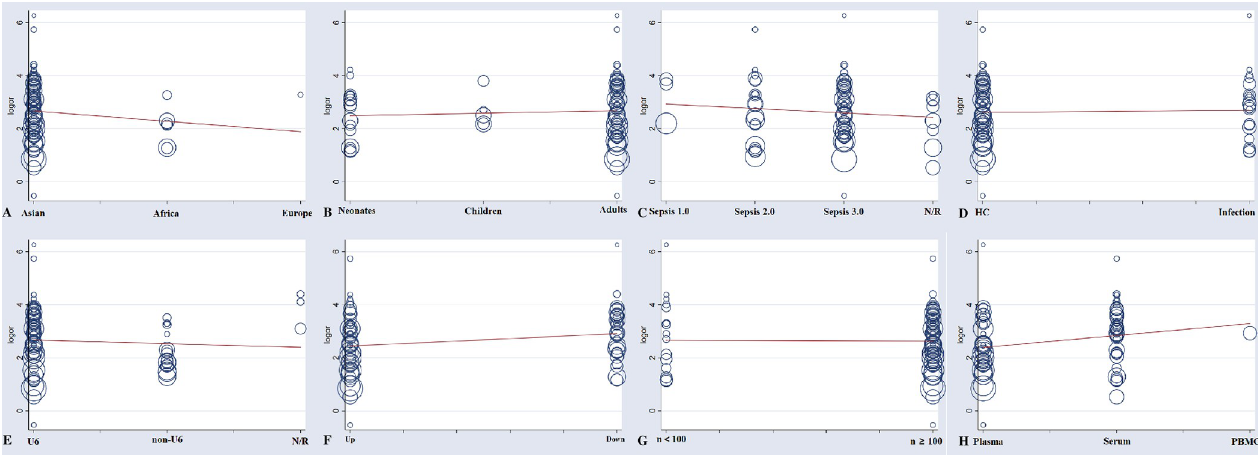
Fig 3. The meta-regression of the enrolled studies. (A) for the region, the meta-regression did not find it was a dramatic impact on the homogeneity of the enrolled studies, P = 0.296, t = -1.05, 95%CI (0.32, 1.42). (B) for the population, the meta-regression found no significant impact on the homogeneity of the enrolled studies, P = 0.519, t = 0.65, 95%CI (0.82, 1.47). (C) for the sepsis diagnostic criteria, the meta-regression did not detect it was a dramatic impact on the homogeneity of the enrolled studies, P = 0.331, t = -0.98, 95%CI (0.60, 1.19). (D) for the controls composition, the meta-regression did not detect it was a dramatic impact on the homogeneity of the enrolled studies, P = 0.76, t = 0.31, 95%CI (0.62, 1.91). (E) for the qRT-PCR reference genes, the meta-regression did not find it was a dramatic impact on the homogeneity of the enrolled studies, P = 0.553, t = -0.60, 95%CI (0.55, 1.38). (F) for the miRNA expression level, the meta-regression did not detect it was a dramatic impact on the homogeneity of the enrolled studies, P = 0.053, t = 1.97, 95%CI (0.99, 2.58). (G) for the total sample size, the meta-regression did not discover a significant impact on the homogeneity of the enrolled studies, P = 0.913, t = -0.11, 95%CI (0.51, 1.82). (H) for the type of samples, the meta-regression detected it was a dramatic impact on the homogeneity of the enrolled studies, P = 0.046, t = 2.03, 95%CI (1.01, 2.43).